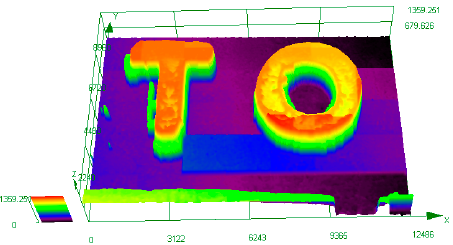
Figure 18. 3D printing experiments performed using EPOX as the monomer, upon irradiation at 405 nm and by using the two-component A5/Iod (0.5%/1%, w / w ) system. Reproduced with permission of Ref. [148].